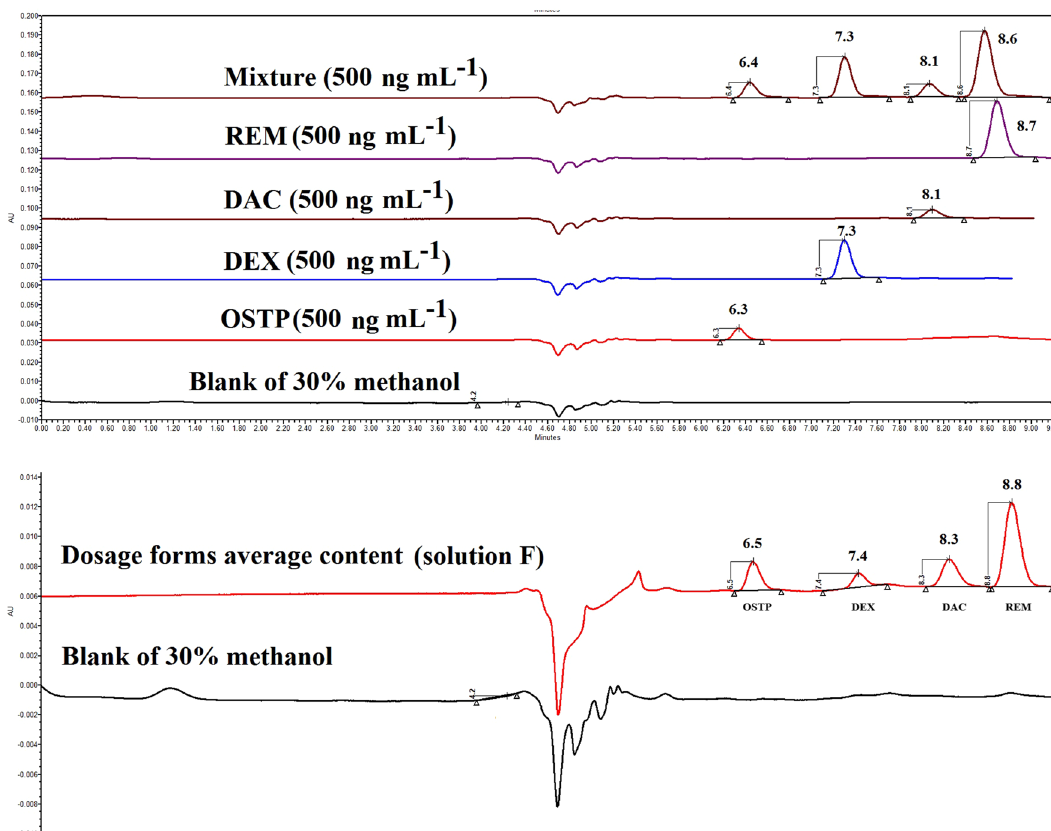
Figure 3. Chromatograms by the proposed method for